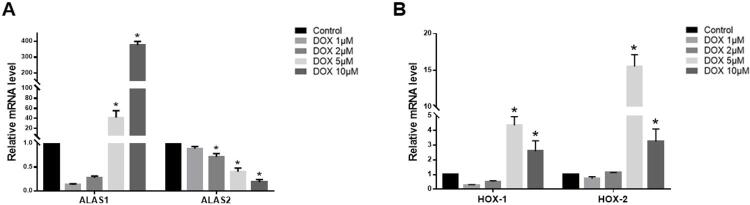
– (A) mRNA expression changes of ALAS1 and ALAS2 under doxorubicin treatment. ALAS1, aminolaevulinic acid synthase 1; ALAS2, aminolaevulinic acid synthase 2. (B) Characteristics of mRNA expression changes for heme catabolic enzymes under doxorubicin treatment. HOX-1, heme oxygenase 1; HOX-2, heme oxygenase 2. * indicate p<0.01 vs. Control group.